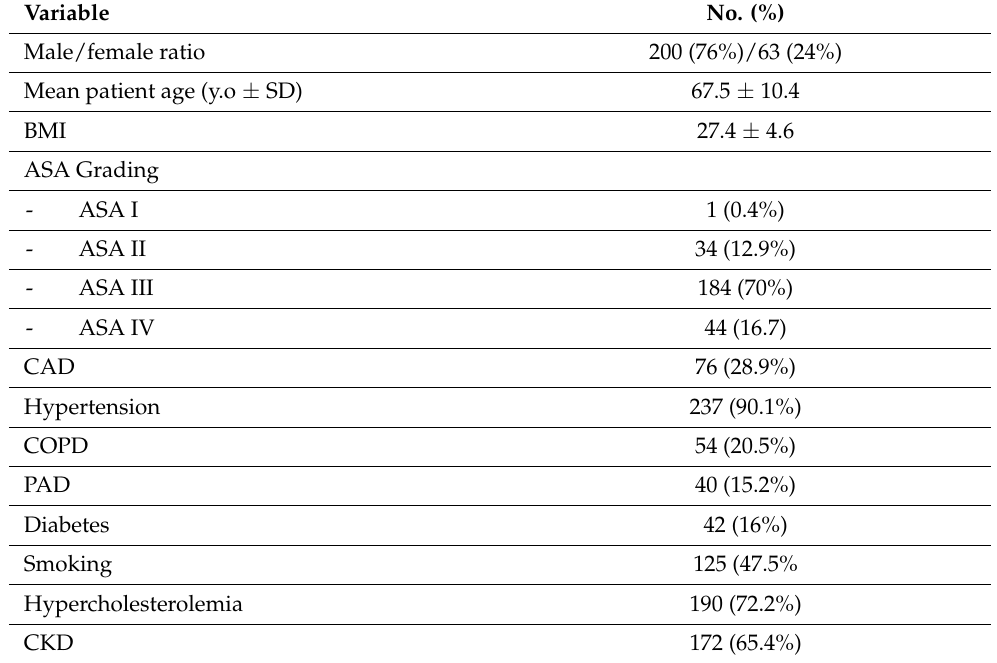
Table 1. Patient demographics. No. = number; y.o = years old; SD = standard deviation; BMI = Body Mass Index; ASA; American Society of Anesthesiology score; CAD = coronary artery disease; hy- pertension = blood pressure > 130/80 mmHg; COPD = chronic obstructive pulmonary disease: PAD = peripheral artery disease; diabetes = HbA1C > 7%; hypercholesterolemia = total cholesterol levels > 200 mg/dL; CKD = chronic kidney